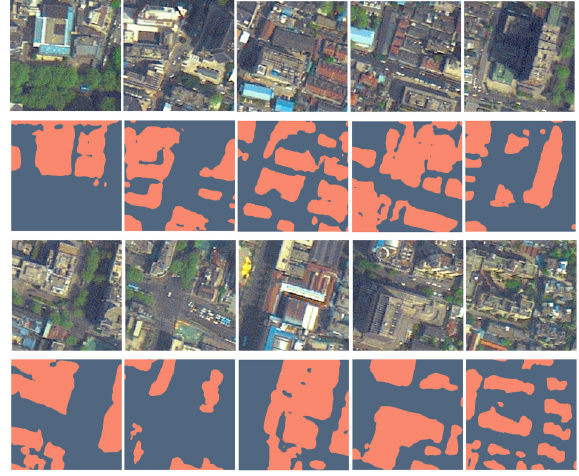
Figure 7 The buildings were extracted by the trained model.